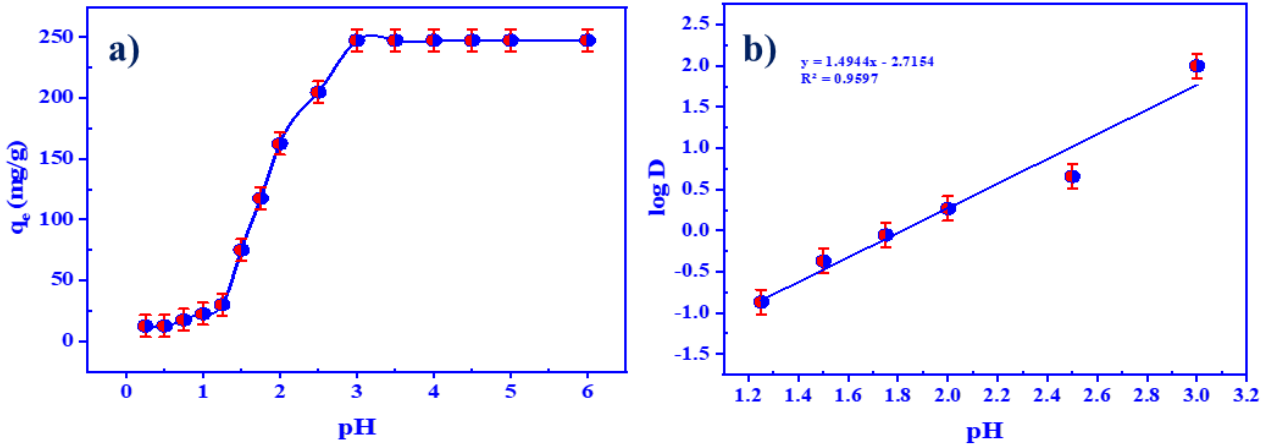
Figure 5. ( a ) The influence of pH on the retention of uranium by HTIP chelating ligand; ( b ) the regression analysis of U(VI) ion extraction by HTIP at various pH values. (U(VI) conc.: 0.42 × 10 − 4 mol/L, HTIP/CHCl 3 conc.: 0.99 × 10 − 3 mol/L (10 mg/25 mL), A/O 1:1, T: 25 °C, time: 30 min).